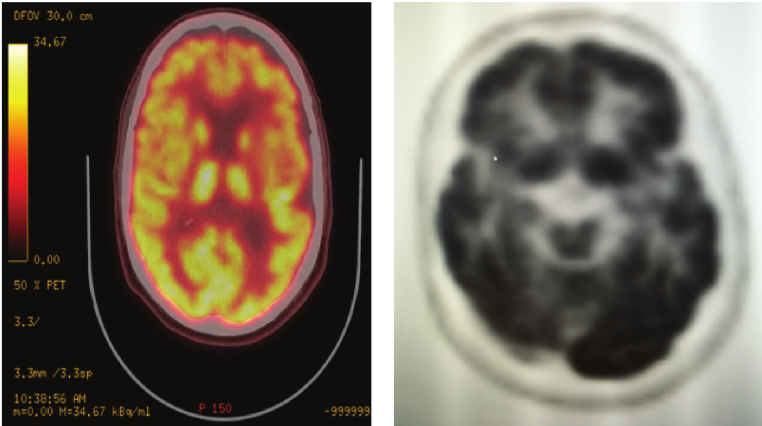
Figure 4: PET scan of the brain showing no hypermetabolic lesions in the brain to suggest lymphoma. Hypometabolism is seen in the right frontal operculum and left frontal vertex. There is a larger area of subtle asymmetric decreased FDG activity seen in posterior left frontal lobe and left parietal